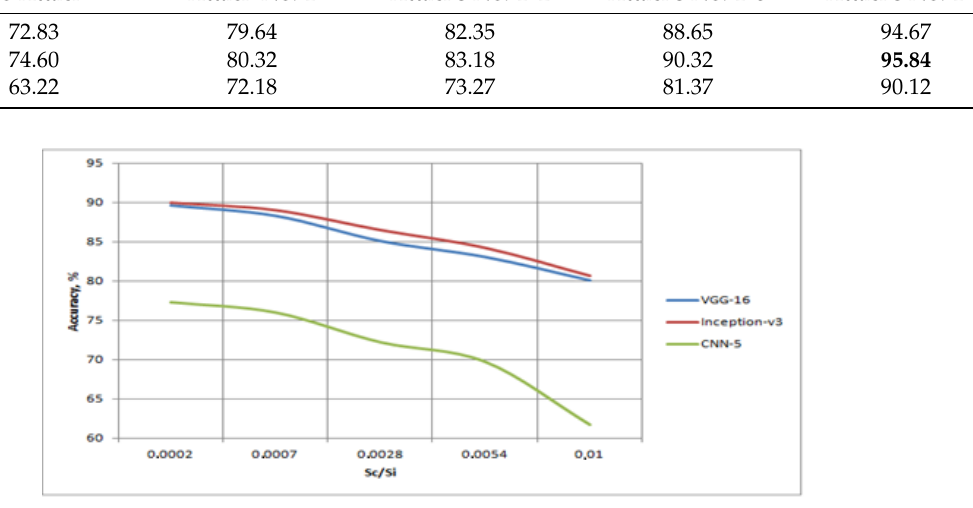
Table 2. Dependence of the proportion of correct recognitions on the size of the distorted area. Table 3. Percentage of correct MNIST.DIGITS image recognitions without prevention of visual attacks. Architecture Architecture